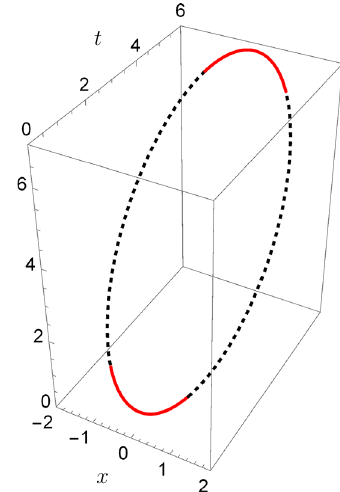
Fig. 8 AnexampleofaclosedspacelikecurveatvaryingPoincarétime t , given by (85) with τ = π/ 5 ,(cid:3) = π/ 4. The top and bottom, shown in solid red, have tangent geodesics lying fully within the Poincaré wedge. This is not true for the segments on the sides, shown in dashed black, which violate the condition (84) and are therefore nonreconstructible. As described in the main text, the tilted oval seen here is the Poincaré counterpart of the global circle shown in the right image of Fig.